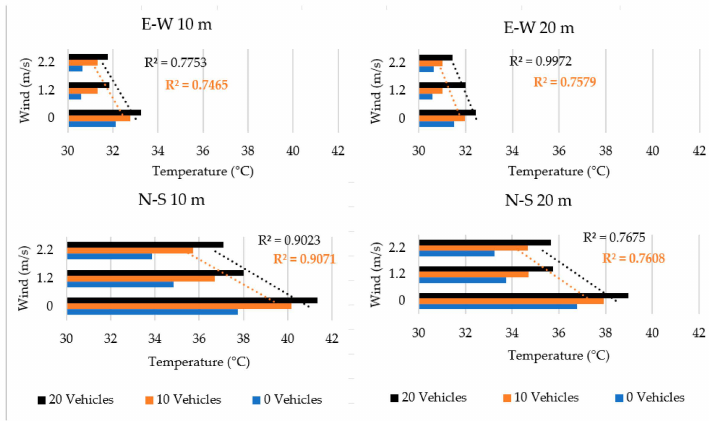
Figure 6. The behavior of different urban canyons, in relation to the increase in the number of vehicles.